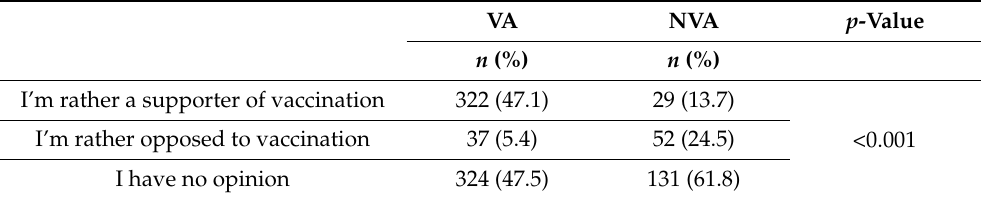
Table 7. Athletes’ attitudes toward COVID-19 vaccination broken down by vaccinated (VA, n = 683) and unvaccinated (NVA, n = 212) against COVID-19.